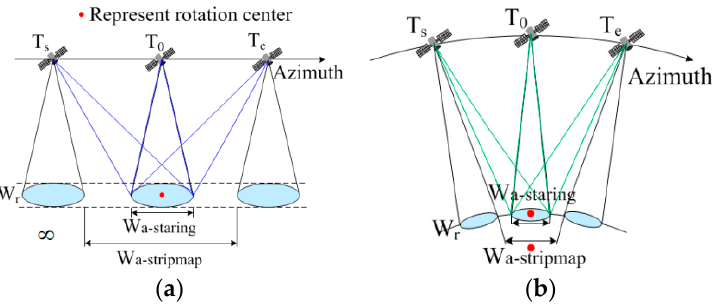
Figure 8. Imaging mode geometrical model comparison. ( a ) Leo-SAR. ( b ) Geo-SAR. Similarly, Figure 8b shows the Geo-SAR geometric model of different imaging